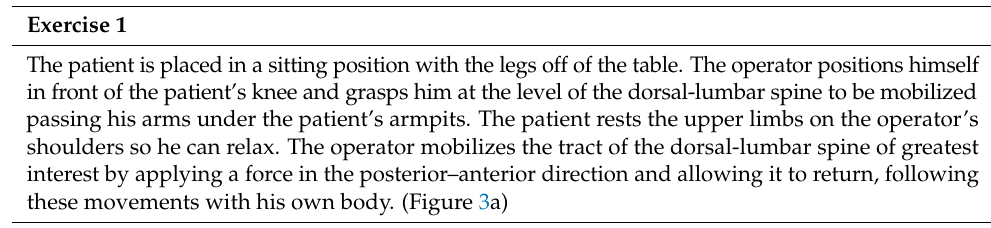
Table 2. Spinal mobilization interventions description. Spinal Mobilizations